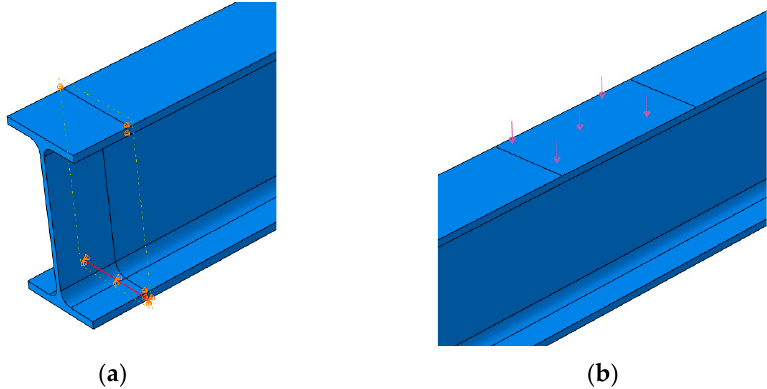
Figure 17. Constraints and loading of the steel beams: ( a ) Application of the constraints; ( b ) Application of the loads.